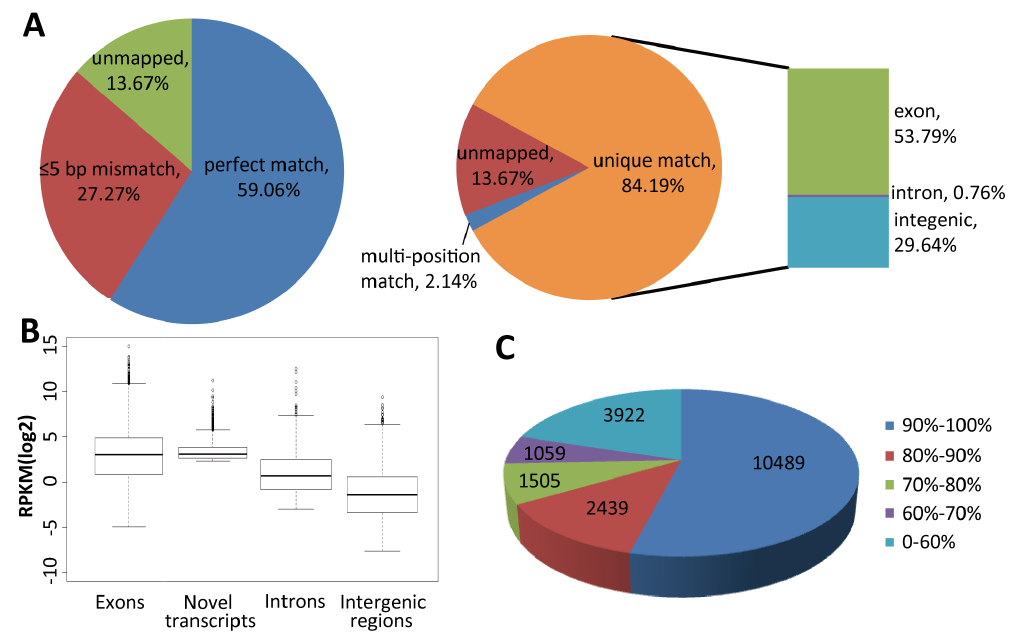
Figure 1. Summary of RNA sequencing of A.flavus CA43. (A) Matching summary of ssRNA-seq reads to the A. flavus genome. (B) Box and whisker plots of log 2 -transformed RPKM for exons, novel transcripts, introns and intergenic regions. Horizontal lines in boxes, the first, median and third quartile. Other horizontal lines, the inner boundaries. Diamonds, data outside the inner boundaries. (C) Mapping coverage of the transcribed A. flavus genes.